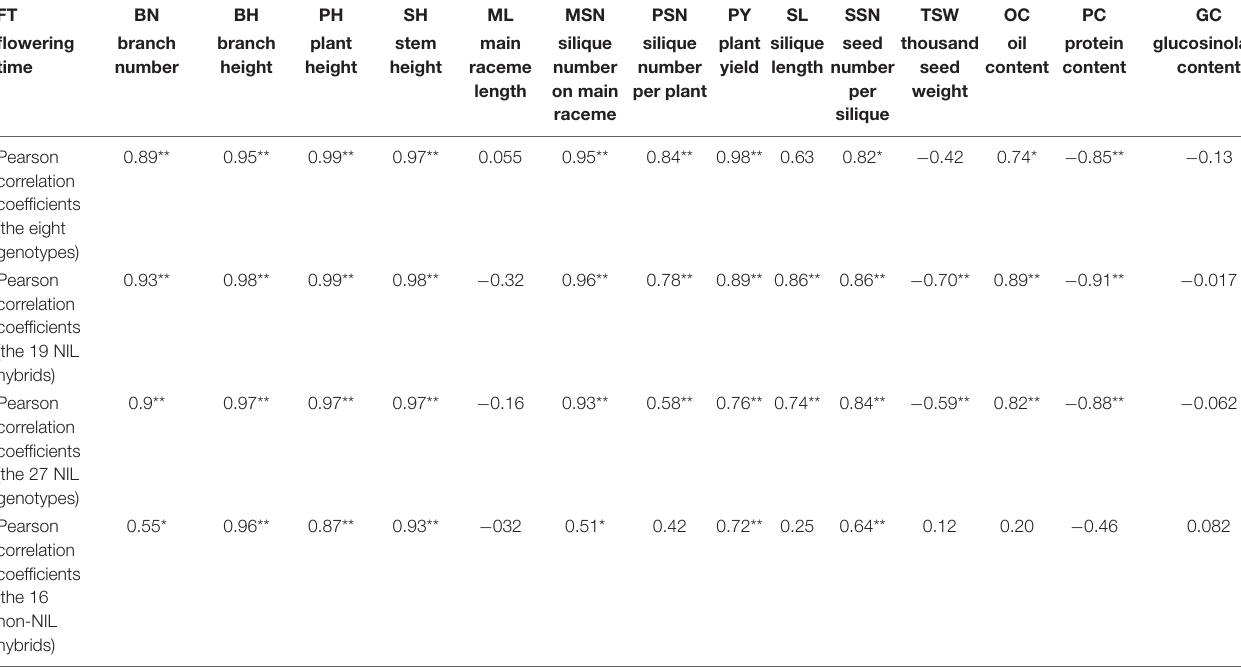
TABLE 2 | The Pearson correlation coefficients between flowering time and other